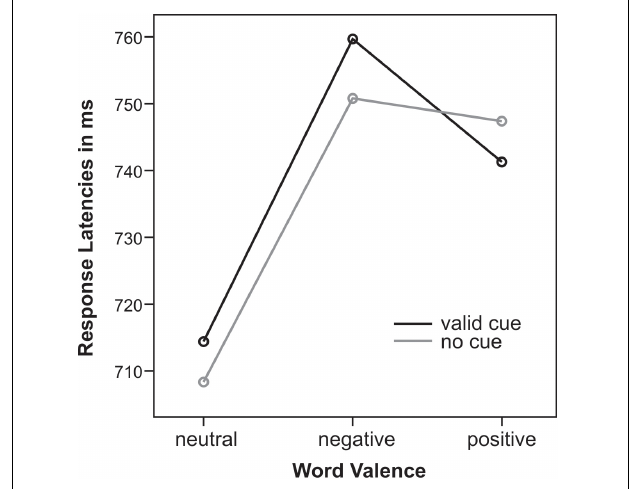
FIGURE 4 | Response latencies in ms for valid cues (black) and no cues (gray) for neutral, negative, and positive